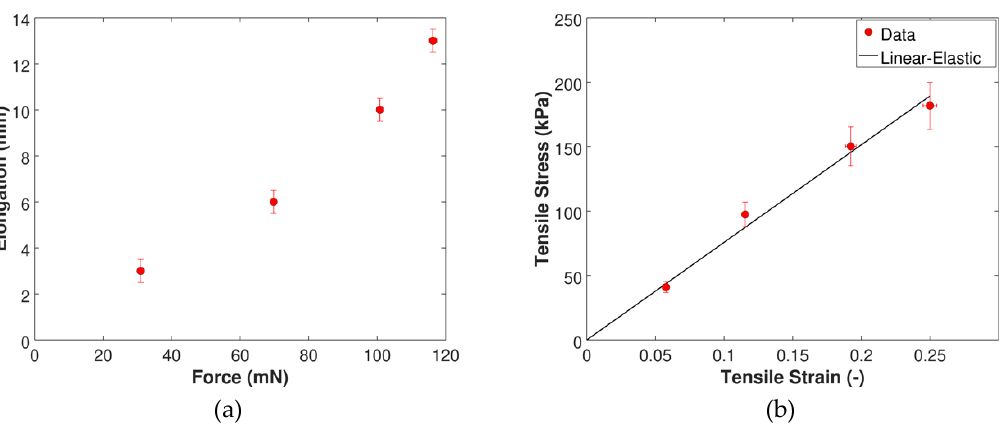
Figure 1. Mechanical characterization of the flexible filaments. ( a ) Uniaxial tensile tests results; ( b ) Stress-strain curve.